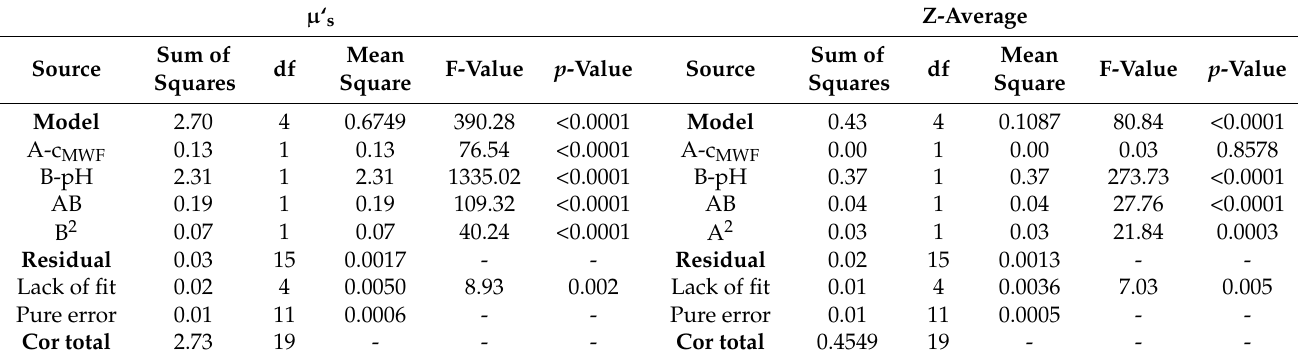
Table 3. Analysis of variance (ANOVA) for responses µ ’ s and Z-average. µ ‘